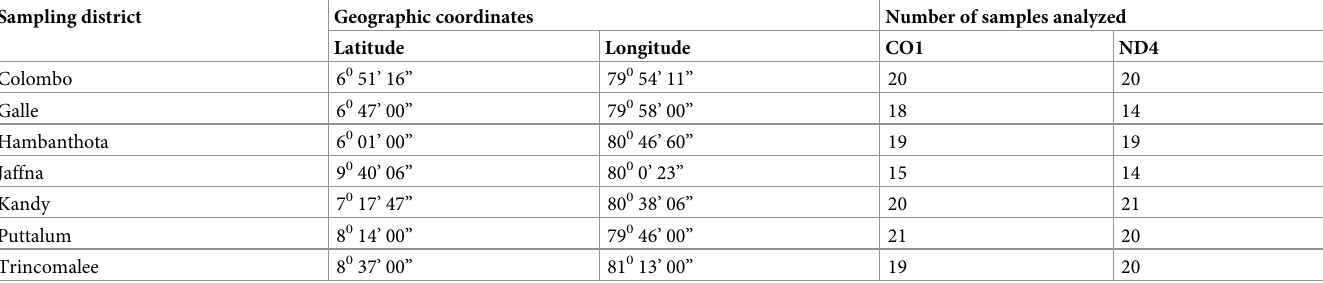
Table 1. Sampling districts, geographic coordinates and the number of Ae . aegypti samples analyzed per each mitochondrial region. Sampling